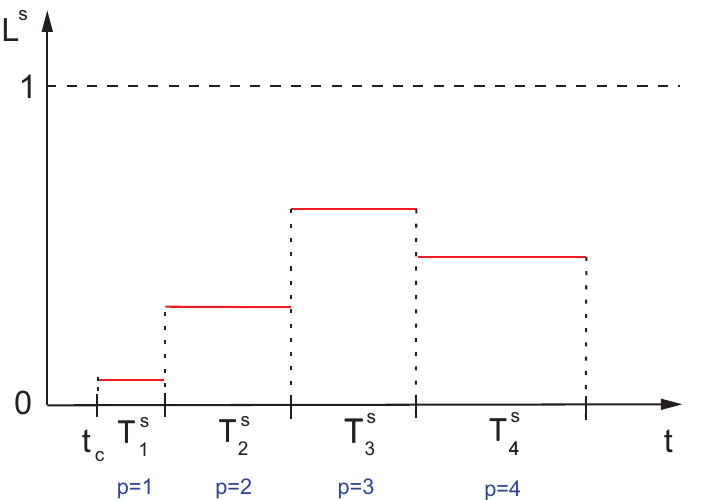
Figure 2. Exemplary possible failure scenario; L s —level of likelihood of failure of the service s during time interval T s consisting of 4 subintervals: T s